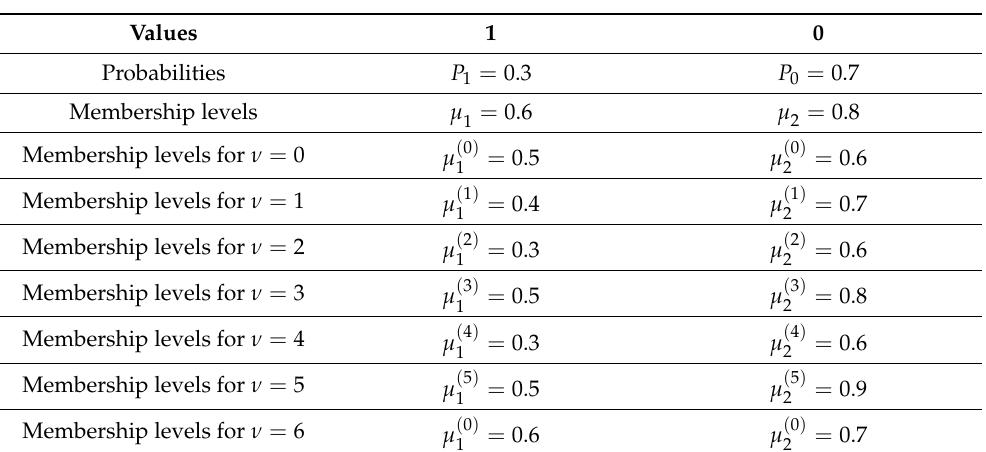
Table 8. Sequence of the membership levels of (cid:101) B ν